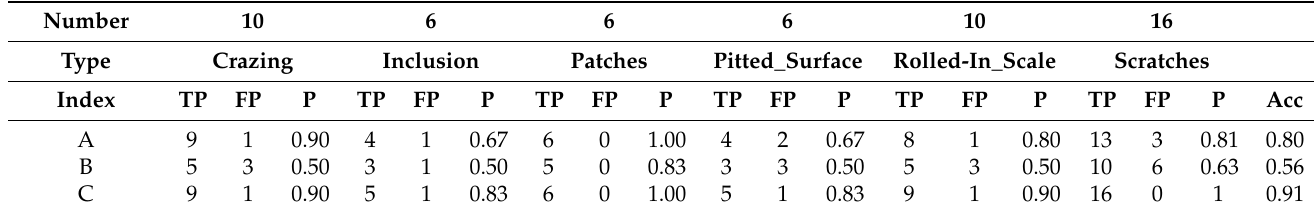
Table 10. Comparison of simulated industrial defect detection